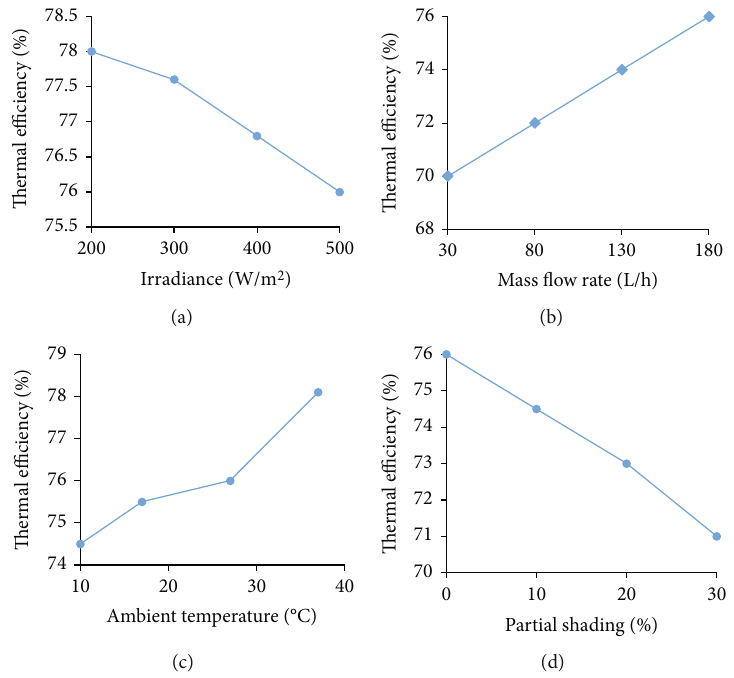
Figure 17: Outcome of (a) G , (b) V